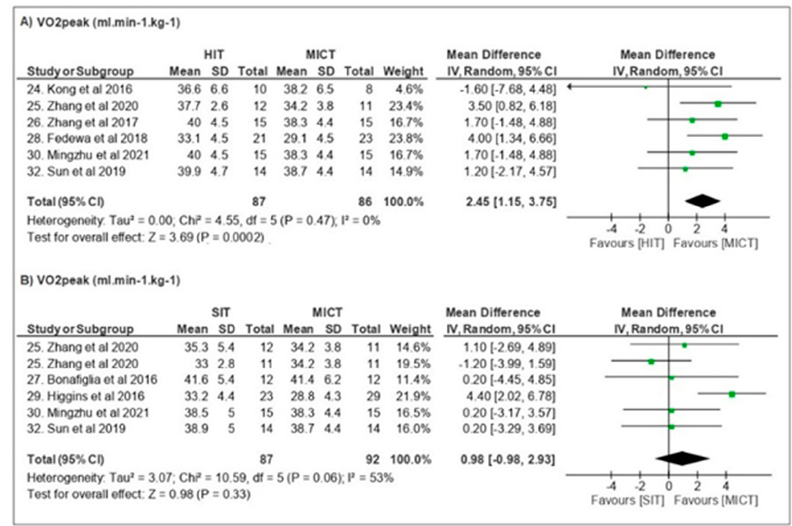
Figure 4. Forest plot of VO 2 peak: ( A ) HIT vs. MICT; ( B ) SIT vs. MICT.